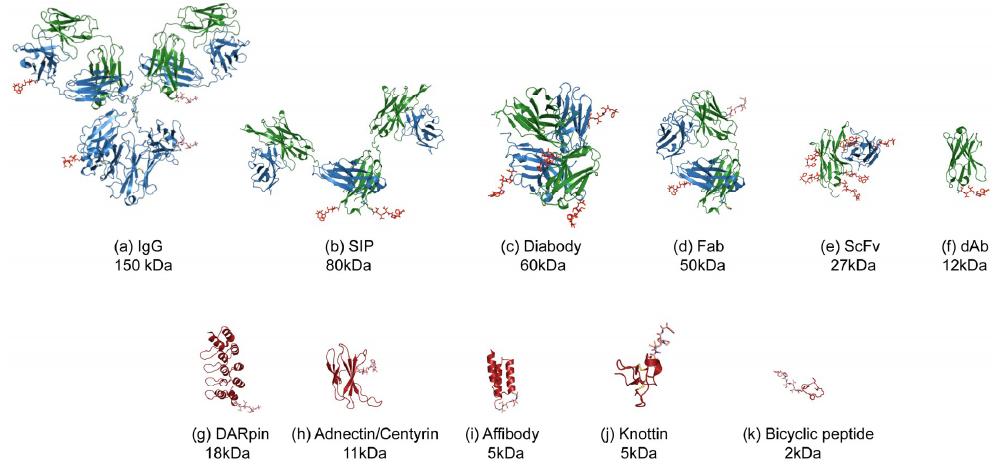
Figure 1. Illustration of the various formats for Antibody (Fragment) or alternative scaffold–drug conjugates. The protein or peptide formats are drawn to scale with an MMAE payload using published Protein Database files (https://www.rcsb.org) as follows: ( a ) IgG-DAR4, 1igy [12], ( b ) SIP-DAR2 (modelled on 5c2b [13]), ( c ) diabody-DAR4, 5fcs [14], ( d ) Fab-DAR2, 5n2k [15], ( e ) scFv-DAR8, 5c2b [13], ( f ) dAb, VH domain-DAR1, 5tsj [16], ( g ) DARPIn-DAR1, 4j7w [17], ( h ) Adnectin-DAR1, 3qwr [18], ( i ) Affibody-DAR1, 1lp1 [19], ( j ) Knottin-DAR1 1w7z [20], ( k ) Bicycle-DAR1, 5i8m [21]. The